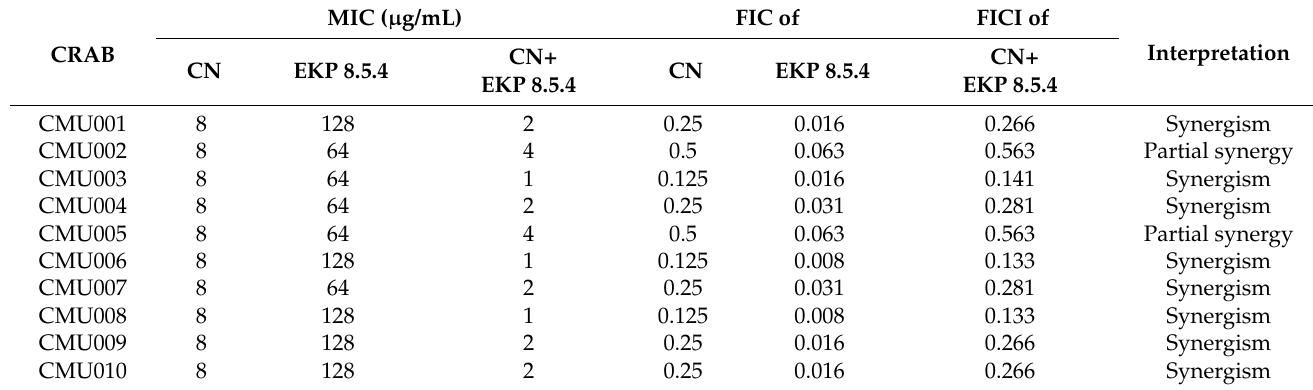
Table 9. Combination effect of gentamicin and EKP 8.5.4 extract against CRAB.